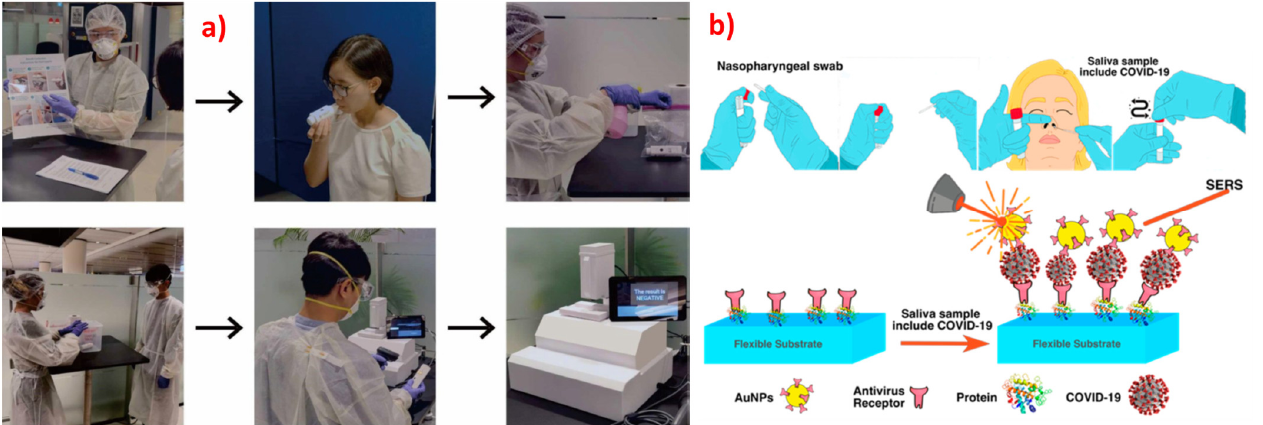
Figure 5. ( a ) Optical images of the workflow used for SERS-based detection of COVID-19 disease using breath analysis with a detection time of 5 min, achieving sensitivity >95% in nearly 500 participants, establishing the rapidness and specificity of SERS. Reproduced with permission from [53]. Copyright (2022), American Chemical Society. ( b ) Schematic of nasopharyngeal-swab-based Covid detection using SERS with flexible substrates enabling sensitive detection. Reproduced with permission from [238]. Copyright (2022), MDPI.